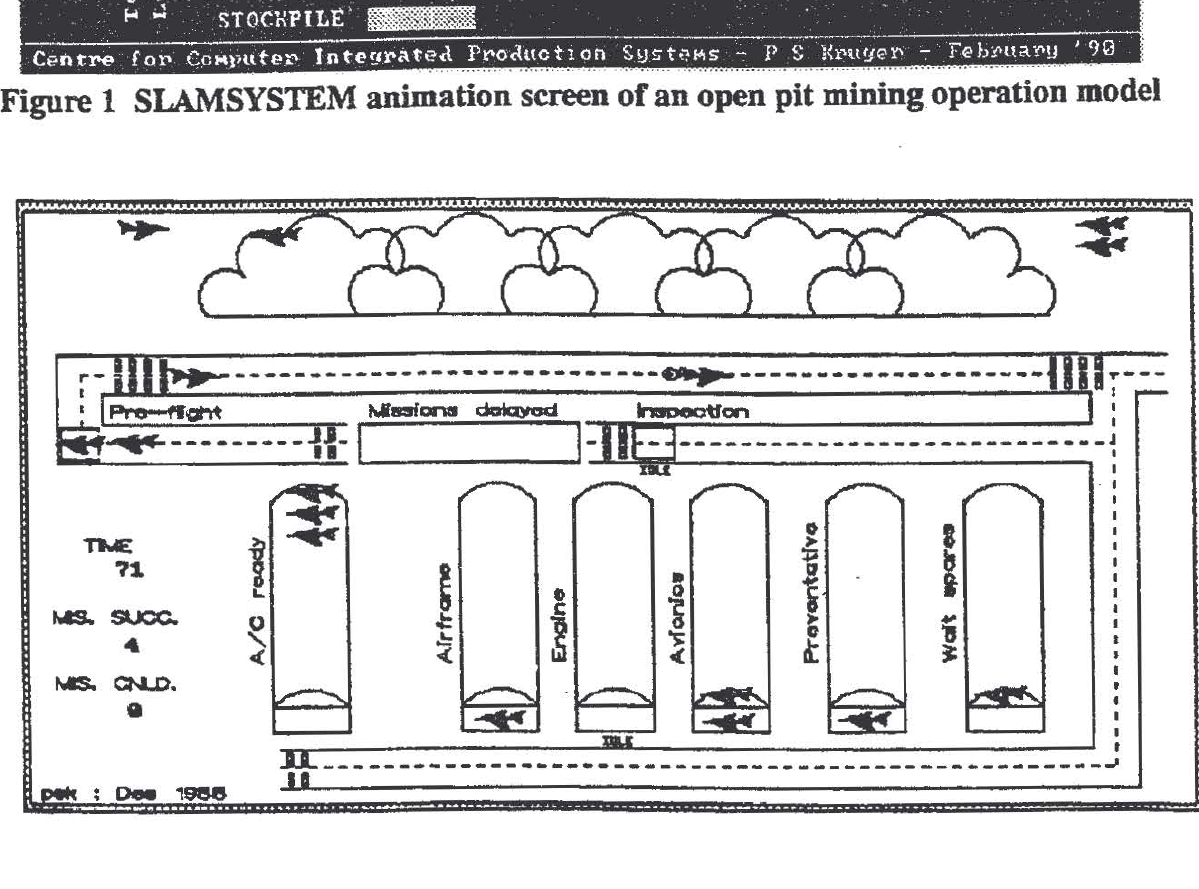
Figure 2 SIMAN/CINEMA animation screen of an air force squadron